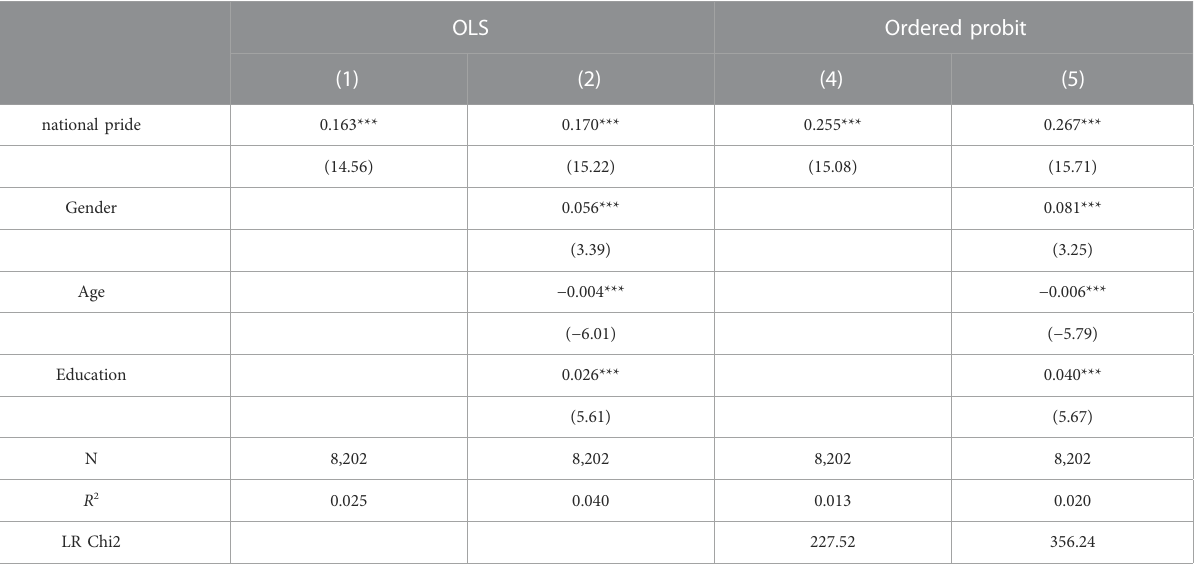
TABLE 1 Regression analysis for Study